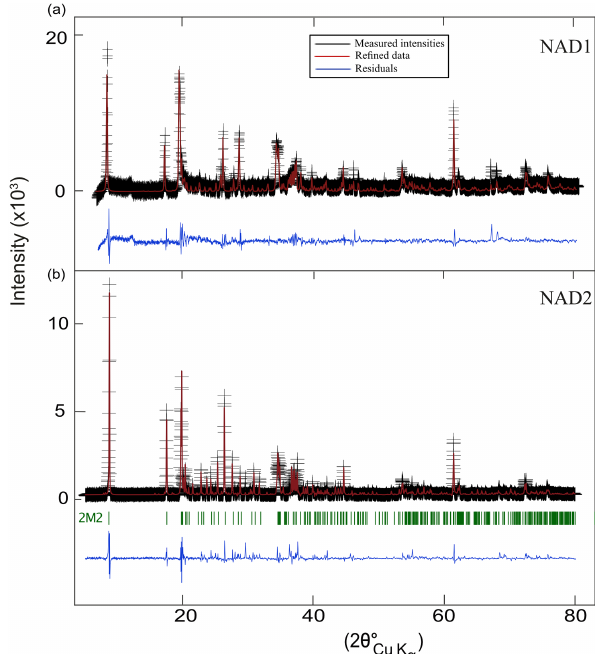
Figure 1. Rietveld refinement of the XRD patterns of the synthetic samples (a) NAD1 and (b) NAD2. Black: measured intensities; red: refined data; blue: residuals. Reflections of the 2M2 polytype as the main polytype in NAD2 are shown